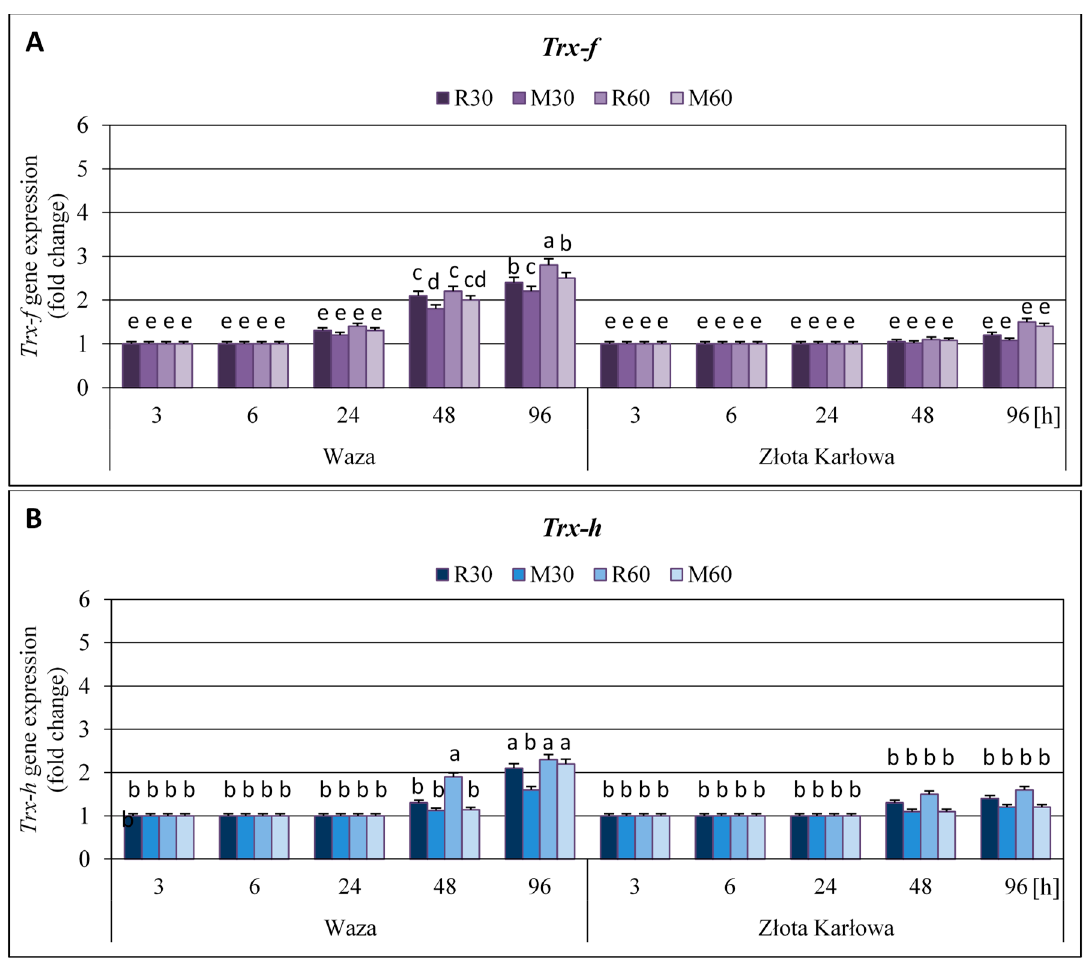
Figure 2. Aphid-stimulated alternations in relative expression of Trx-f ( A ) and Trx-h ( B ) genes in the leaves of maize seedlings (Waza and Złota Karłowa cvs). R30, R60—maize seedlings of a given cultivar infested with 30 and 60 R. padi females per plant, respectively; M30, M60—maize seedlings of a given cultivar infested with 30 or 60 M. dirhodum females per plant, respectively. Results represent n-fold changes in expression of the examined genes in the aphid-stressed maize seedlings, compared to the non-infested controls. Data were derived from three independent experiments (mean ± SD). Di ff erent letters (a, b, c, d, e) above error bars indicate significant di ff erences between the level of Trx genes’ expression ( p < 0.05; post-hoc Tukey’s test).